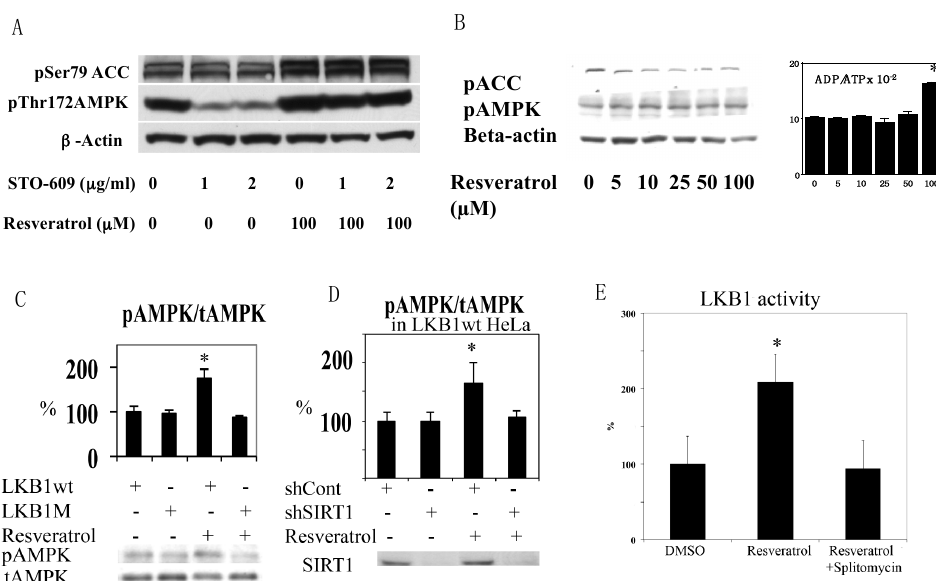
Figure 3. ( A ) Resveratrol-induced activation of AMPK. HEK293 cells were stimulated by 100 µM resveratrol in the presence of the indicated concentrations of CamKK inhibitor STO-609. AMPK activation was clearly seen with inhibition of CamKK (compare lanes 2 vs. 5 and lanes 3 vs. 6); ( B ) Resveratrol failed to activate AMPK in HeLa cell. HeLa cells were stimulated with the indicated concentrations of resveratrol for 1 h. Although 100 µM resveratrol increased the ADP/ATP ratio ( n = 3), it failed to change AMPK activity; ( C ) HeLa cells with wt LKB1 restore AMPK activation by resveratrol. HeLa cells were infected with lentivirus expressing wild type (wt) or K194A (kinase dead) mutant (M) LKB1 and stimulated with 100 µM resveratrol for 1 h ( n = 3); ( D ) Resveratrol activation of AMPK is SIRT1 dependent. HeLa cells infected with wt LKB1 were infected with scramble shRNA (shCont) or SIRT1 shRNA (shSIRT1), and were stimulated with 100 µM resveratrol for 1 h ( n = 3); ( E ) Resveratrol activates LKB1 kinase activity, which was prevented by the Sir2 inhibitor splitomycin. Human umbilical vein endothelial cells were incubated with 100 µM resveratrol or 100 µM resveratrol + 50 µM splitomycin for 1 h. The whole cell lysate was immunoprecipitated with LKB1 antibody and kinase activity was measured with LKBtide and 32 P -ATP. 100 µM resveratrol increased kinase activity by 100% ( n = 3, * p < 0.05) and this was prevented by splitomycin.